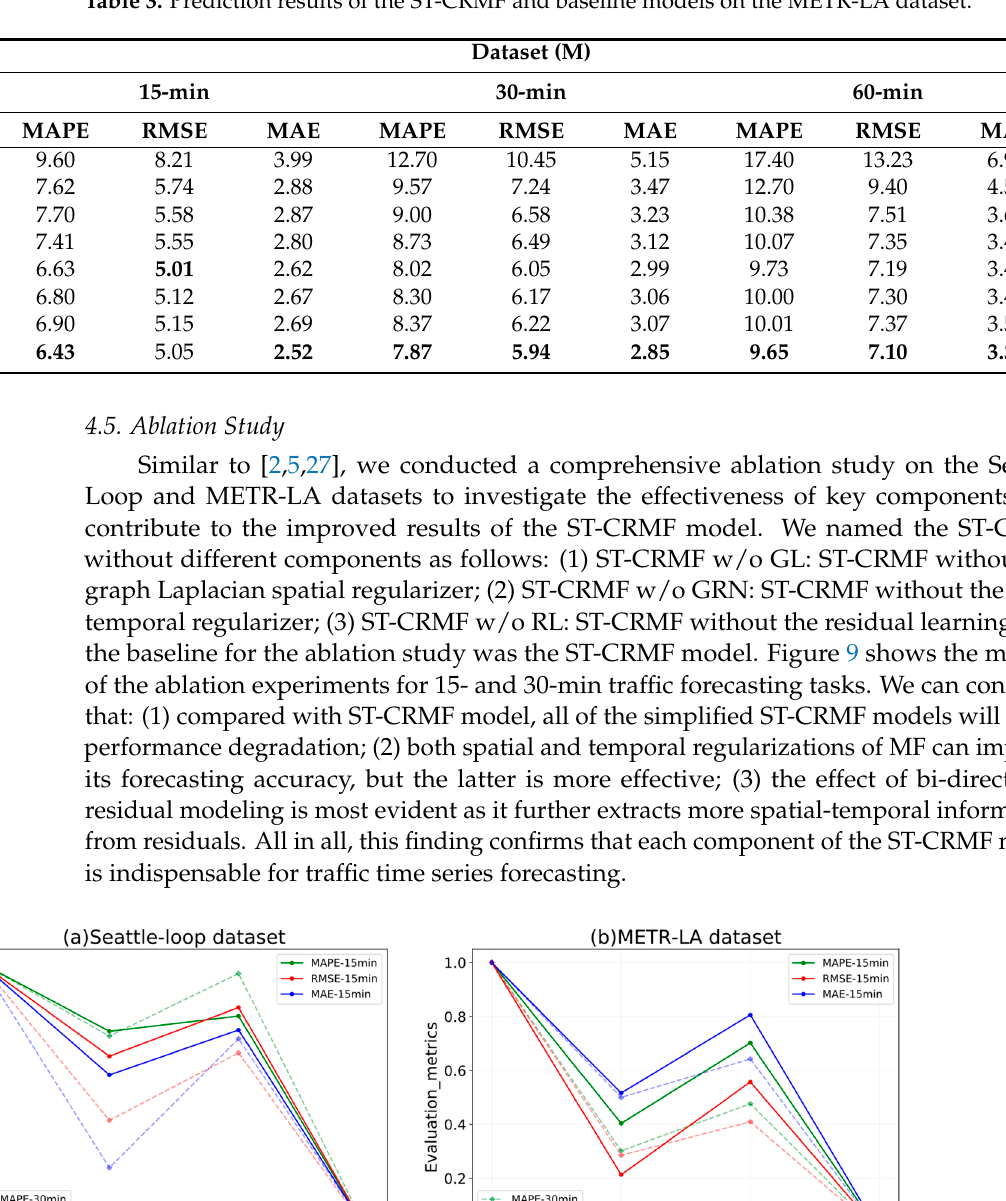
Table 3. Prediction results of the ST-CRMF and baseline models on the METR-LA dataset.